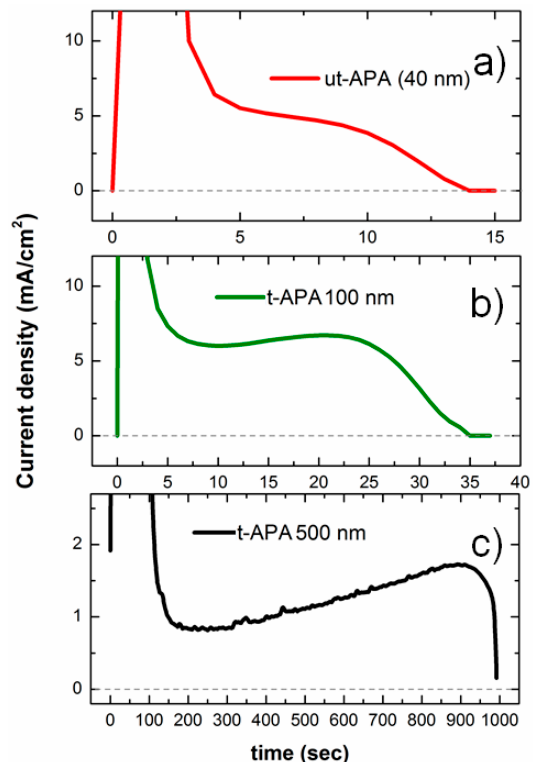
Figure 1. Typical chronoamperometric curves measured during anodization of Al on glass substrates for ultra-thin anodic porous alumina (utAPA, ( a ) thickness 40 nm) and thin anodic porous alumina (tAPA) with different thickness (( b ) 100 nm and ( c ) 500 nm).